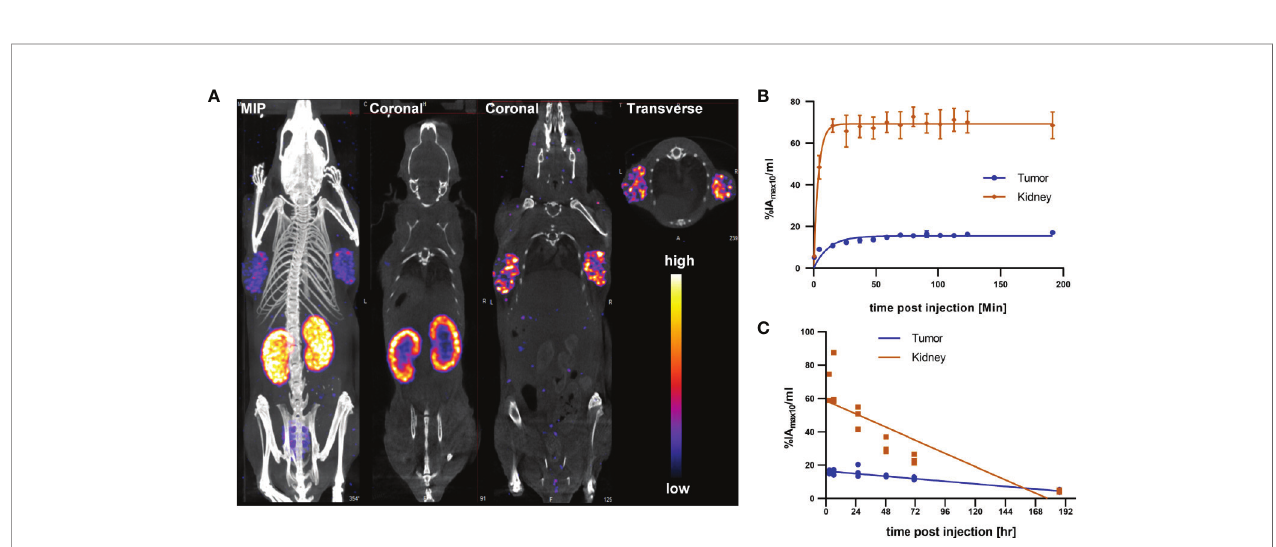
FIGURE 3 | SPECT/CT imaging with 177 Lu-DOTA-integrin a v b 6 knottin. (A) SPECT images show maximum intensity projection (MIP), coronal and transverse projections fused with CT images of 177 Lu-DOTA-integrin a v b 6 knottin in a Capan-2 xenograft model at 22 hours post injection of 62 MBq tracer. Nude mice were carrying xenografts on left and right shoulder. (B) Early SPECT kinetics data show the uptake of 177 Lu-DOTA-integrin a v b 6 knottin in tumor and kidney. (C) SPECT- based time-activity curve (2-187 hours p.i.) shows faster clearance of 177 Lu-DOTA-integrin a v b 6 knottin from kidney than from